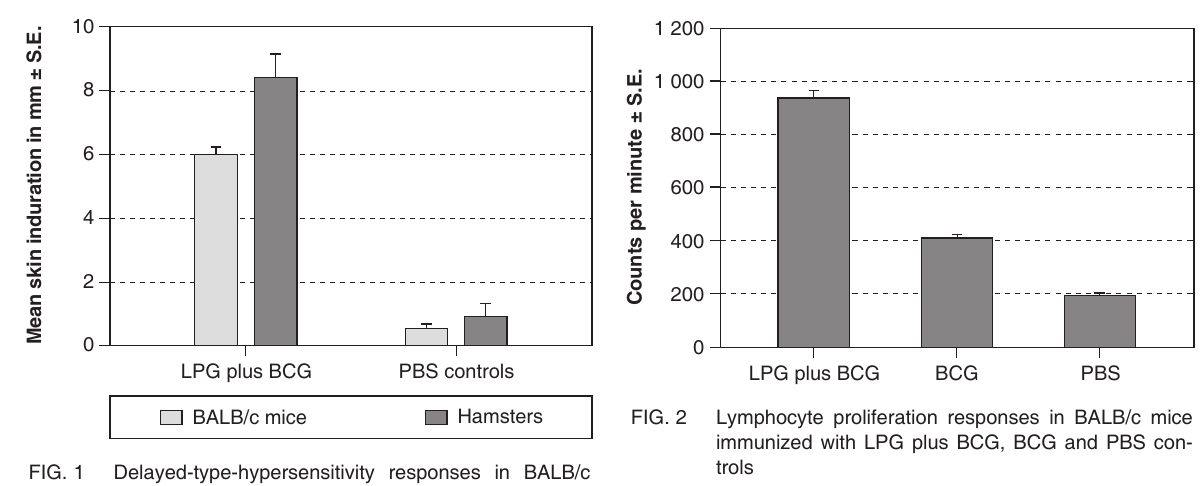
FIG. 2 Lymphocyte proliferation responses in BALB/c mice immunized with LPG plus BCG, BCG and PBS con- trols